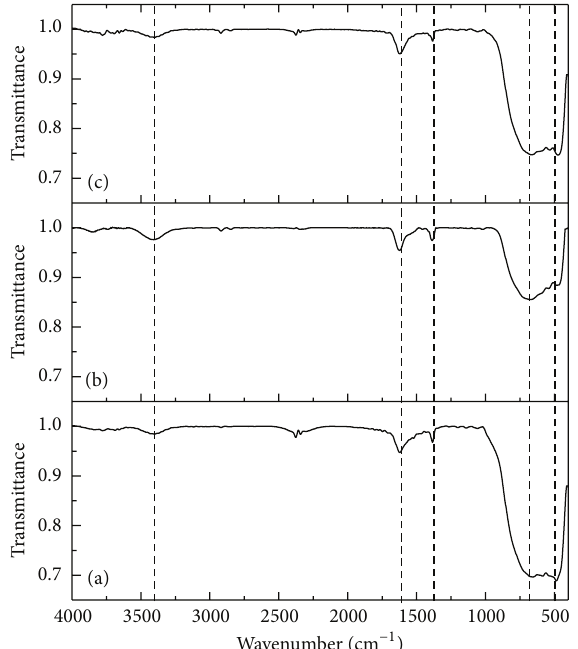
Figure 5: FTIR graphs of synthesized TiO 2 nanoparticles using an activated carbon template in different quantities and with calcination at 500 ∘ C for 3 hr: (a) 0%, (b) 5%, and (c) 10%.